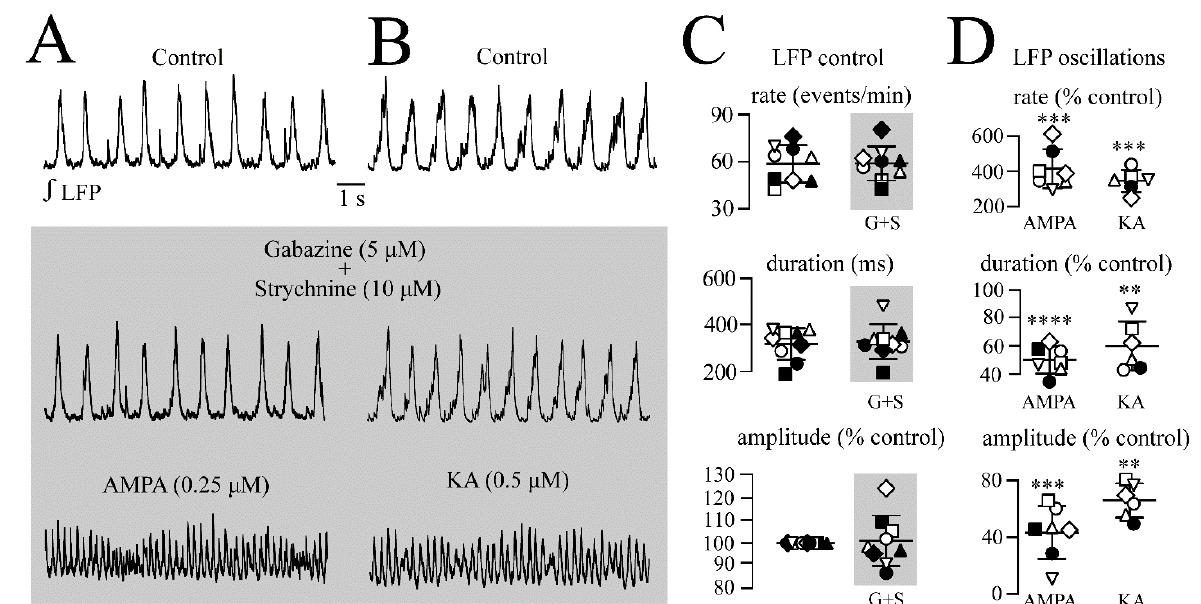
Figure 9. Effects of blockade of Cl - -mediated inhibition on the control rhythm and LFP oscillations. ( A , B ) The addition of gabazine plus strychnine to the control superfusate had no effect on the LFP rhythms in two different slices and further addition of AMPA (in ( A )) or KA (in ( B )) evoked the typical spindle-shaped oscillations. ( C ) summarizes for nine slices (each represented by the same symbol) that gabazine plus strychnine had no effect on the LFP rate, event duration, or the event amplitude. ( D ) Compared to the control rhythm, before adding gabazine plus strychnine, both AMPA (left plots) and KA (right plots) had typical significant effects on the LFP rate, duration, and amplitude. Significance in ( D ) was obtained with two-tailed paired t-test. Significances in ( C , D ) were ** p < 0.01, *** p < 0.001, **** p < 0.0001.